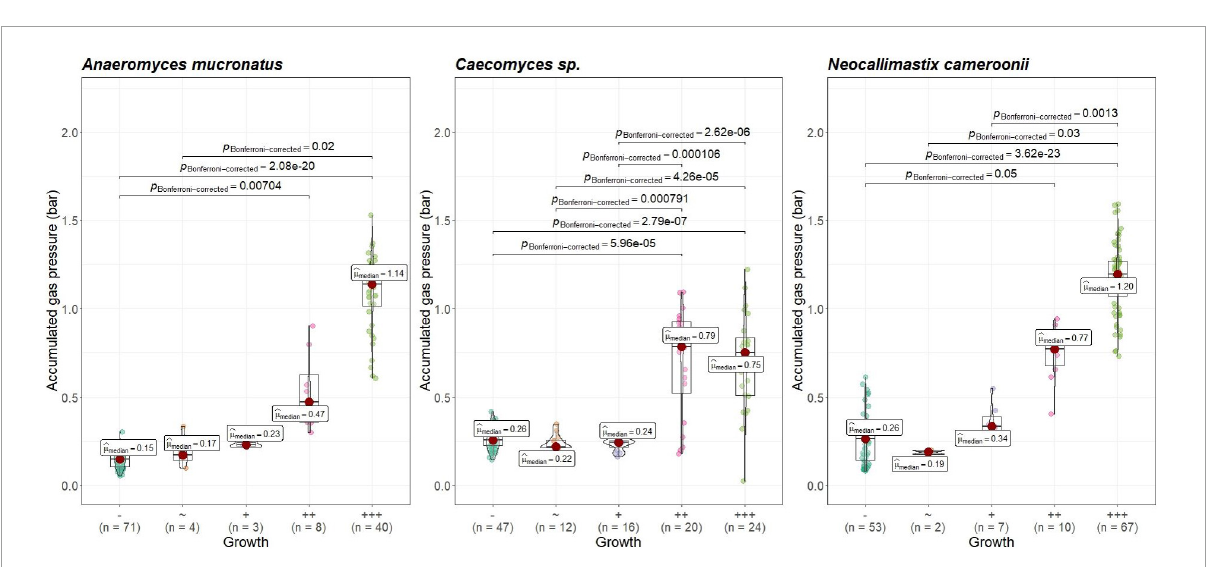
FIGURE8 Correlation between AF visual growth inspection and accumulated gas pressure at lab B. Visual growth evaluation categories: “ –“, no growth; “+++”, very good growth. Statistical tests: Kruskal–Wallis with post hoc Dunn-test. Only significant pairwise comparisons are